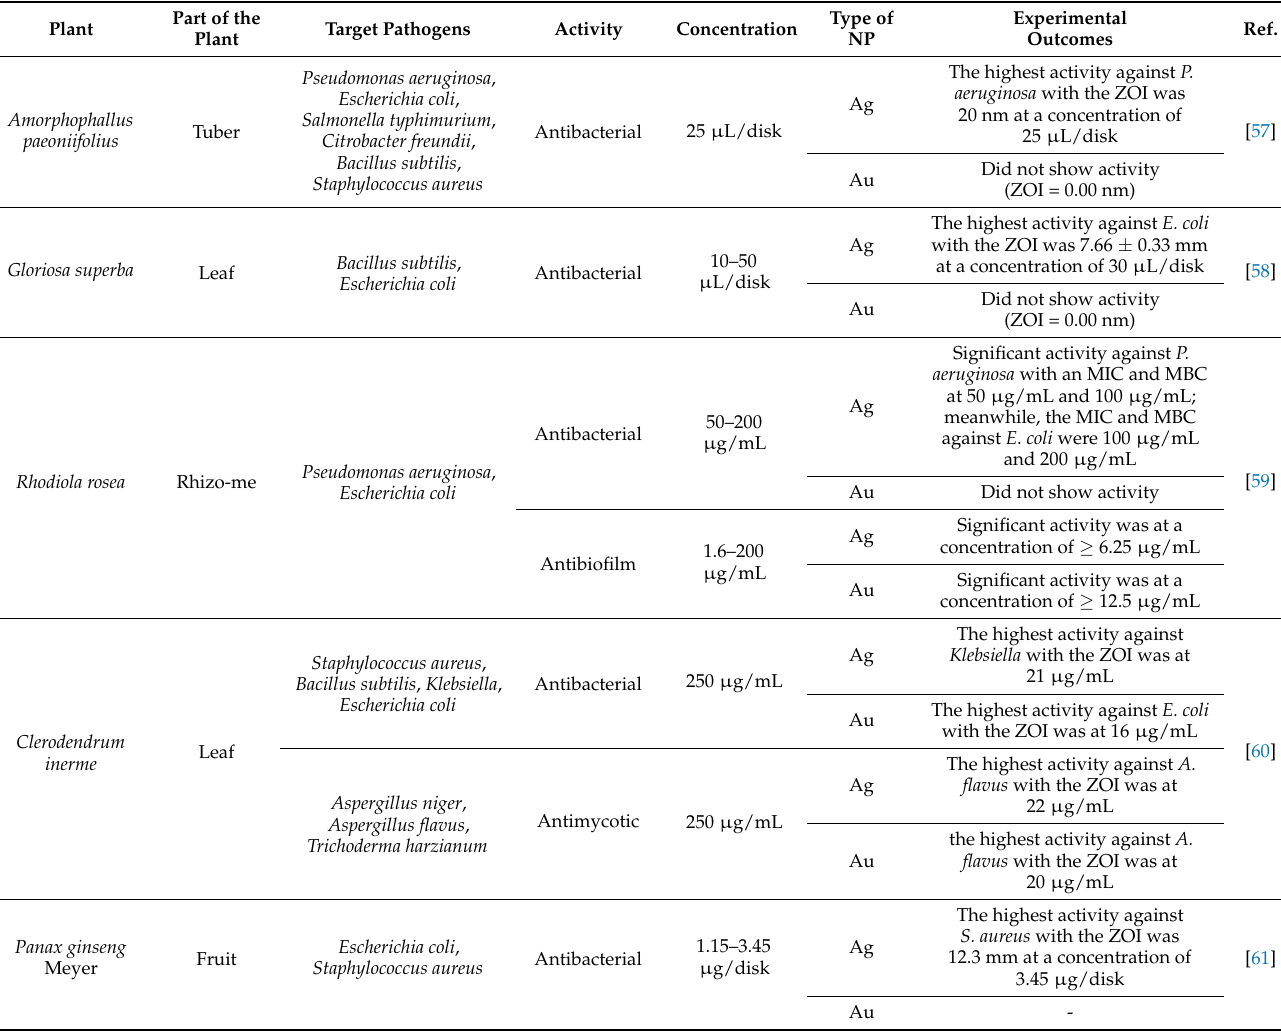
Table 2. Plant-based gold and silver nanoparticles as antimicrobial and anti-biofilm